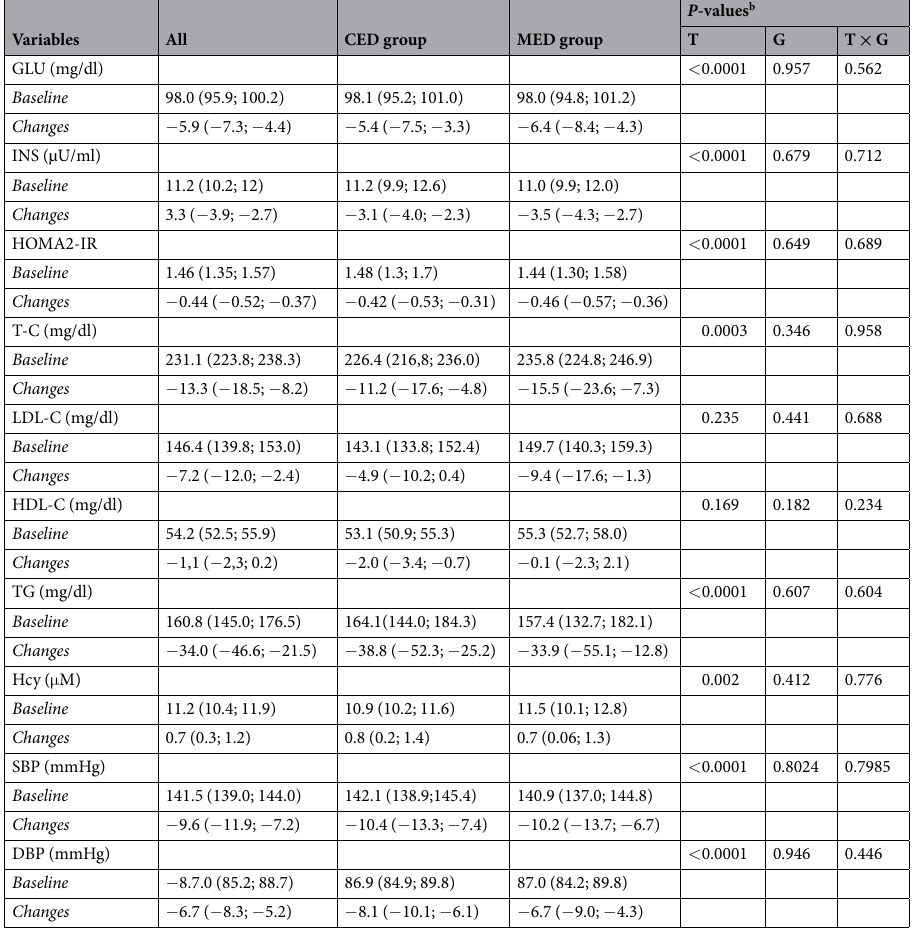
Table 2. Subject characteristics before intervention and changes in biochemical and medical parameters after intervention, analyzed with ITT a . Abbreviations: GLU: glucose; INS: insulin; HOMA2-IR: homeostatic model assessment of insulin resistance; T-C: total cholesterol; LDL-C: low-density lipoprotein cholesterol; HDL-C: high-density lipoprotein cholesterol; TG: triglyceride; Hcy: homocysteine; SBP: systolic blood pressure; DBP: diastolic blood pressure; T: time; G: group; T × G: time–group interaction; a Values are expressed as means (95% CI); b Linear mixed model for values at each time point, significant at P < 0.05; CED: baseline: n = 72; week